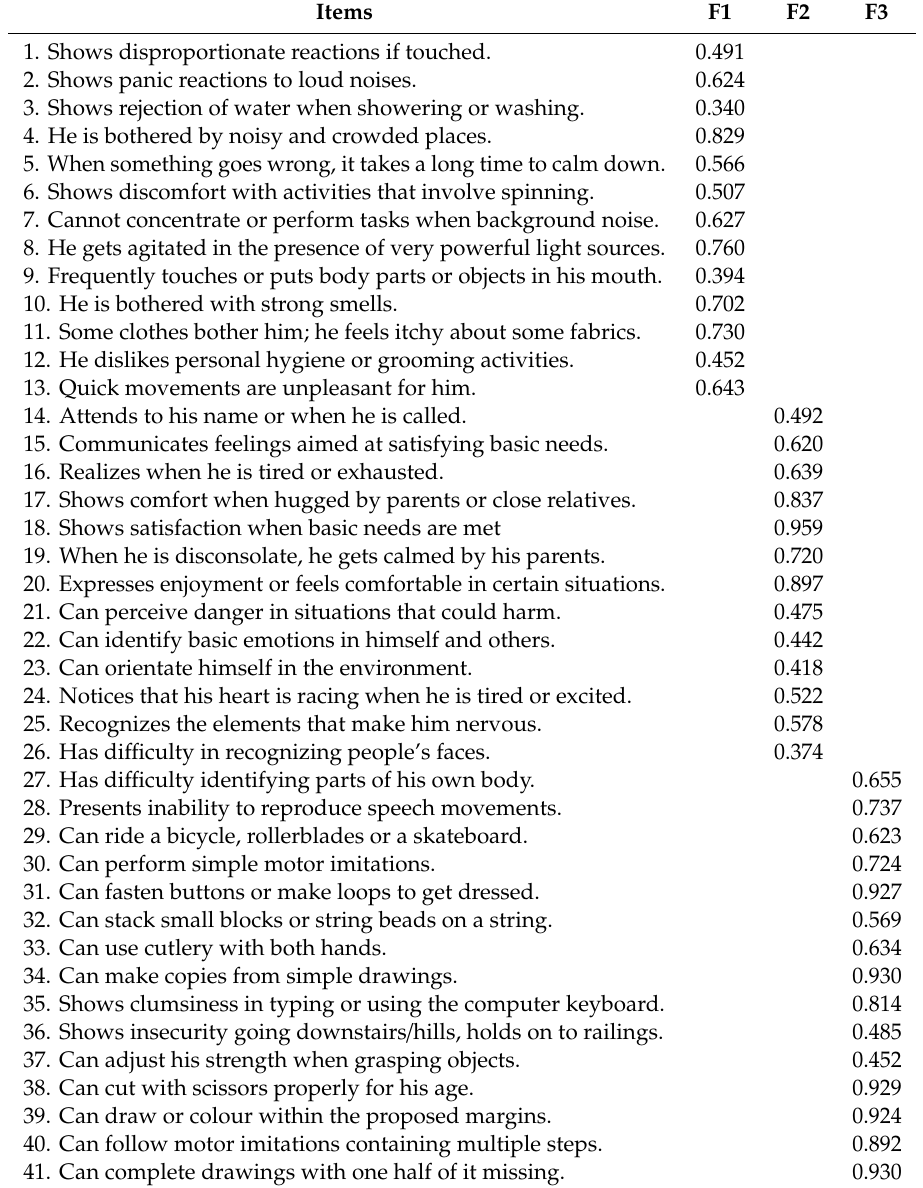
Table 1. Rotated factorial matrix and factorial weights of each item.